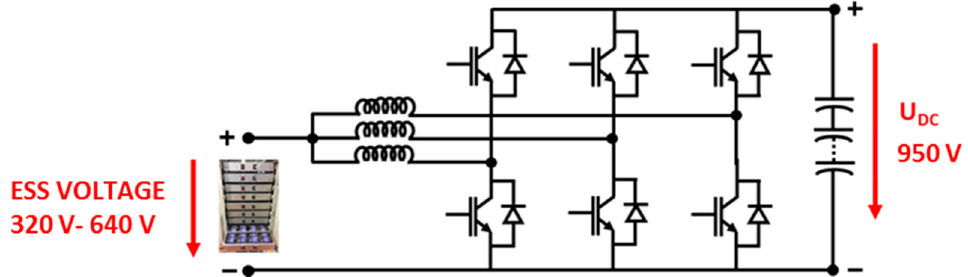
Figure 7. Electrical diagram with the voltage levels at the input and output of the DC/DC converter